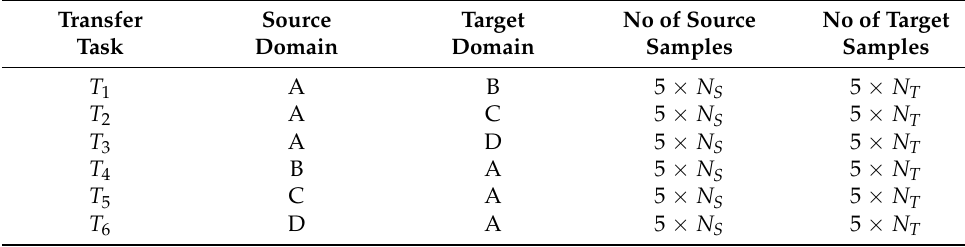
Table 5. Details of each transfer task for Paderborn